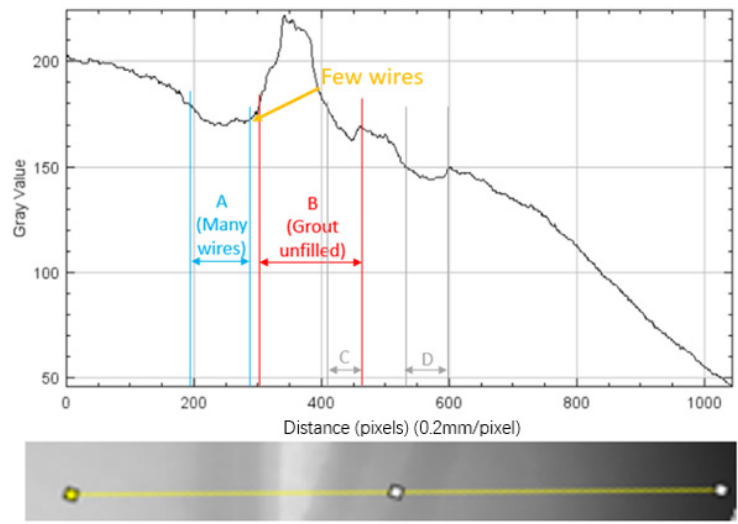
Figure 20. Gray value profile analyzing line.